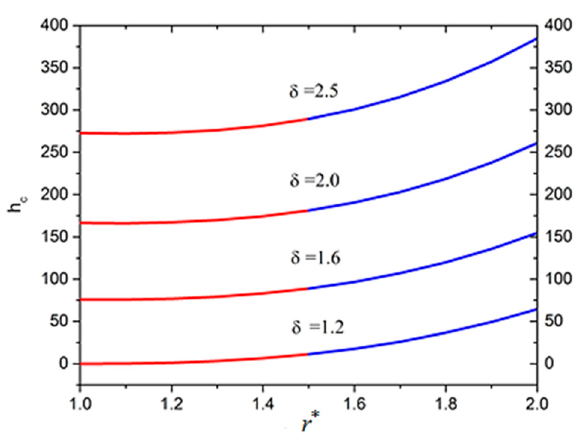
Figure 10. Effect of ε𝐷 (cid:2869)(cid:2870) on thickness of coated fiber optics when 𝑋 (cid:2869) = 0.5, 𝑋 (cid:2869) = 1.0 , δ = 2.